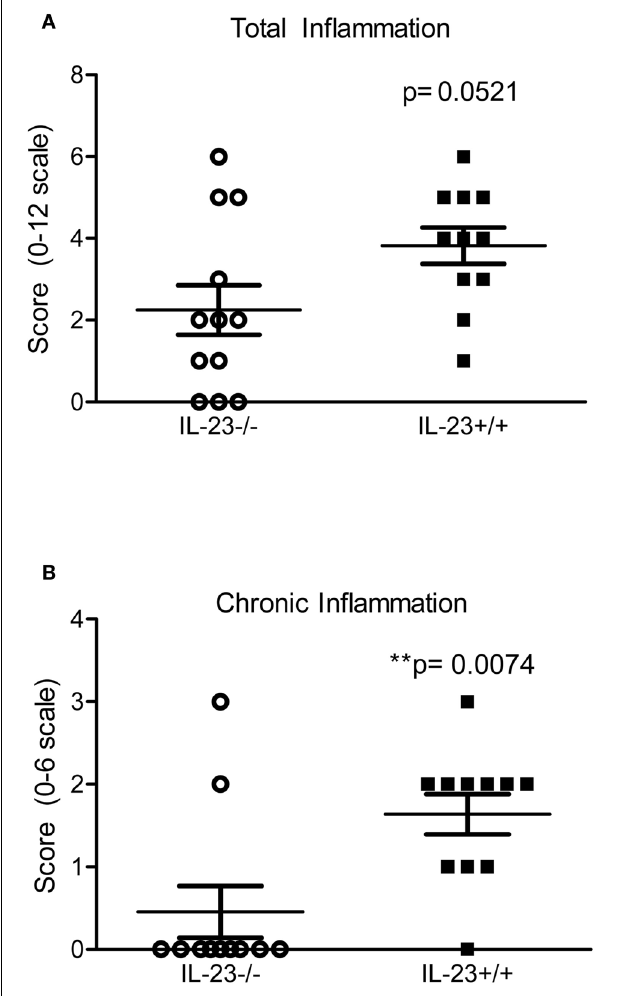
FIGURE 4 | Inflammation is reduced in H. pylori infected IL-23 − / − mice compared to H. pylori infected IL-23 + / + mice. Levels of acute and chronic inflammation were scored on stomach tissue (in the corpus and antrum) at 3months post infection.Total inflammation (A) was scored on